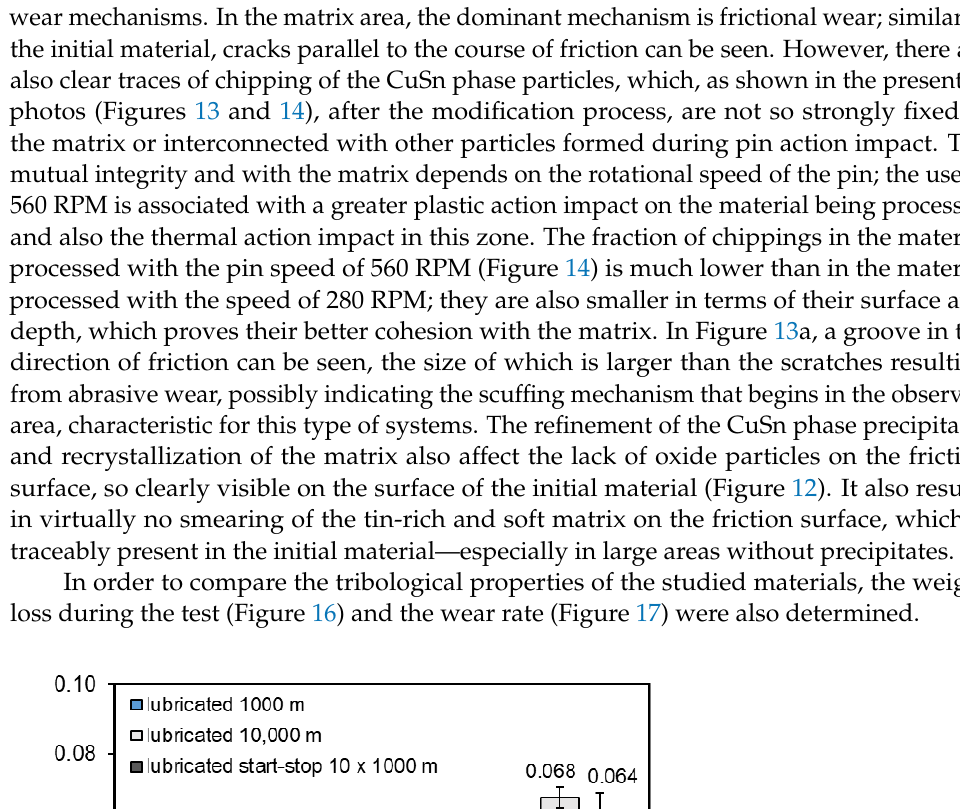
Figure 15. Surface after friction of B89 alloy in initial state and maps of distribution of elements: O, Fe, Sn, Cu, Sb; lubricated friction; SEM EDS.